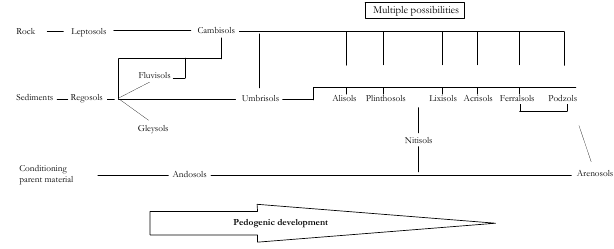
Fig. 20 Fig. 20. Simplified scheme for soil development in